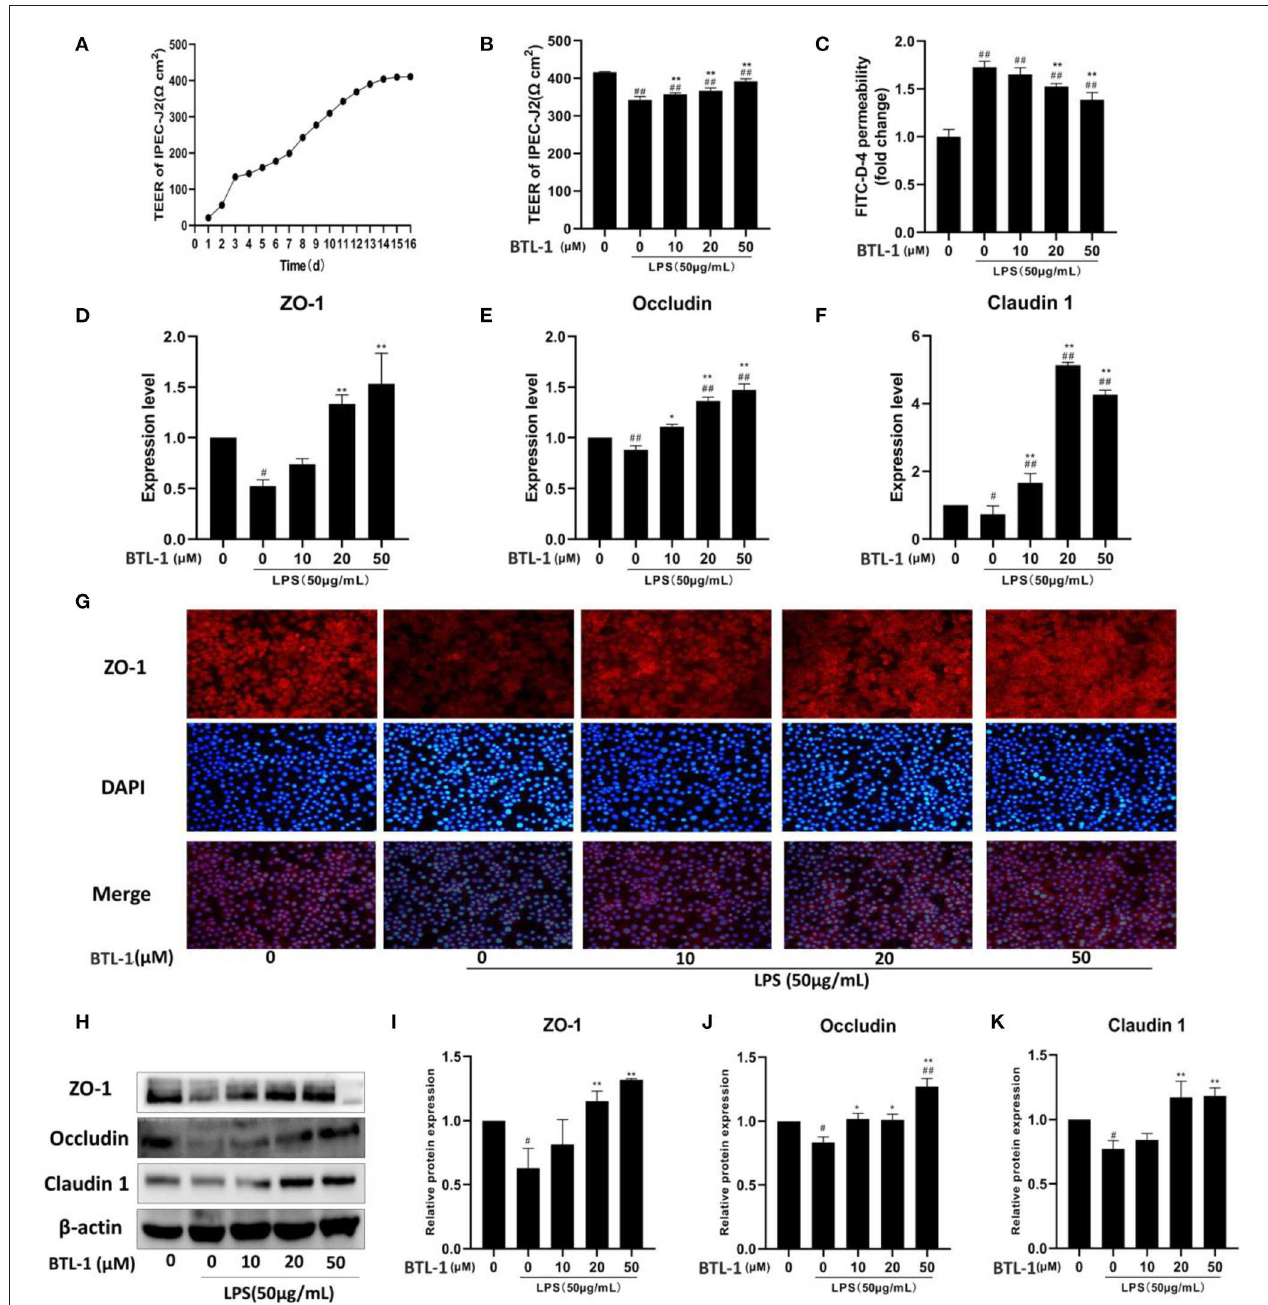
FIGURE 6 | In vitro effect of BTL-1 on intestinal paracellular permeability. Transmembrane resistance of IPEC-J2 monolayer measured by IPEC-J2 cell resistance voltmeter (A) . The effect of BTL-1 on transmembrane resistance in vitro intestinal paracellular permeability was measured by a fluorometer (B) . The effect of BTL-1 on FITC-D fluorescence intensity in the lower compartment measured by a fluorescence microplate reader (C) . The effect of BTL-1 on TJ protein determined by qPCR (D–F) , IF (G) , and western blotting (H–K) . The data are representative of three independent experiments. The results were expressed as the means ± SEM. # P < 0.05, ## P < 0.01, compared to non-treated group, * P < 0.05, ** P < 0.01 compared to LPS group.